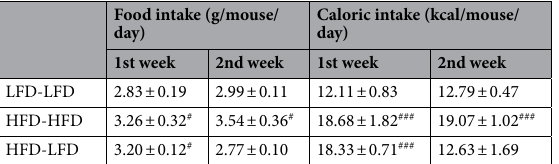
Table 2. Food and Caloric intake of mice fed 14 days with LFD or HFD or 7 days with HFD followed by 7 days with LFD. # p < 0.05, ### p < 0.001 vs.